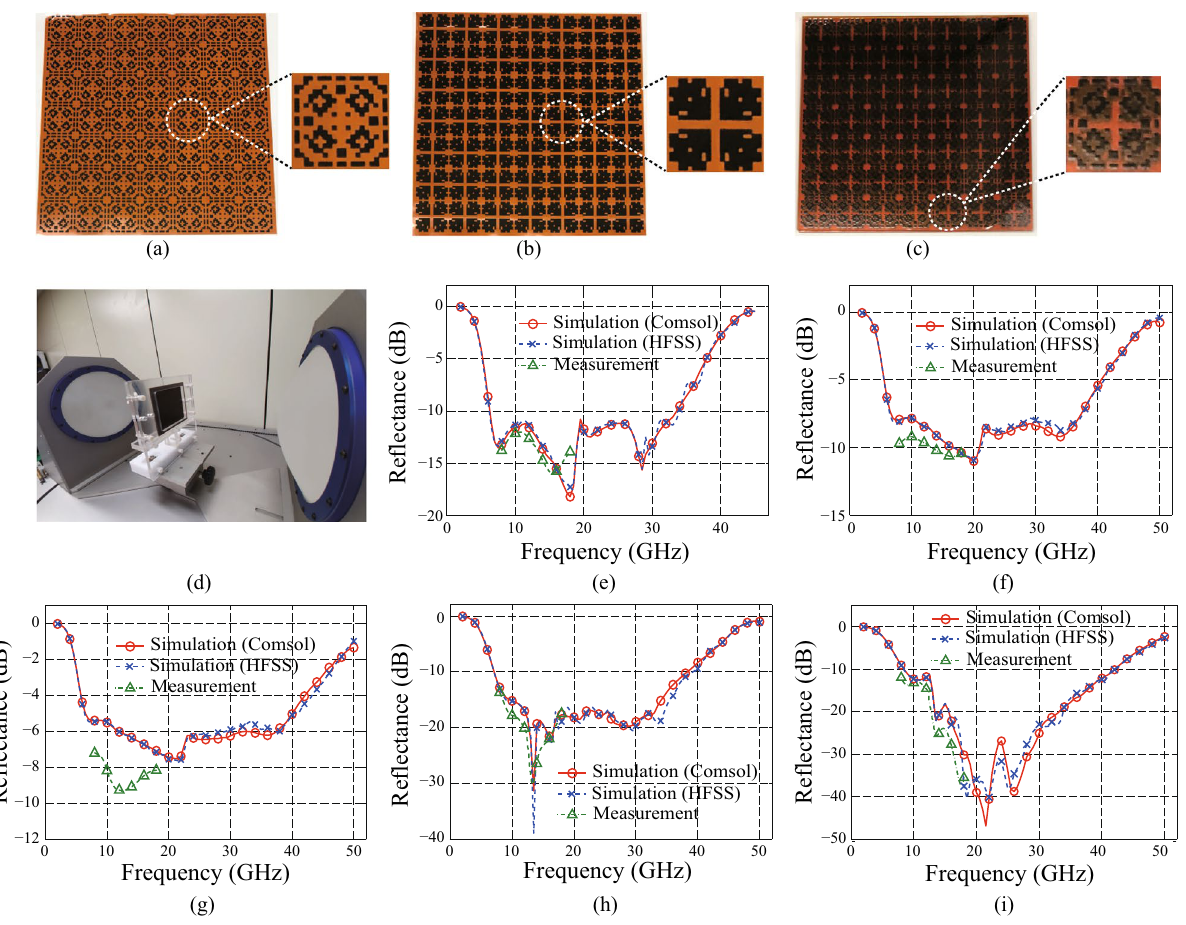
Figure 5. Fabricated metamaterial absorber, measured reflectances, and simulated results via Comsol multiphysics and HFSS using 3D metapatterns with d p = 200 µ m. Fabricated ( a ) top and ( b ) intermediate carbon metapatterns, and ( c ) total structure of the proposed metamaterial absorber. ( d ) Measurement system. ( e ) Measured and simulated reflectances for the normal incidence. Measured and simulated reflectances for ◦ ◦ TE polarization with incident angles ( f ) θ = 45 and ( g ) θ = 60 . Measured and simulated reflectances for TM ◦ ◦ polarization with incident angles ( h ) θ = 45 and ( i ) θ = 60